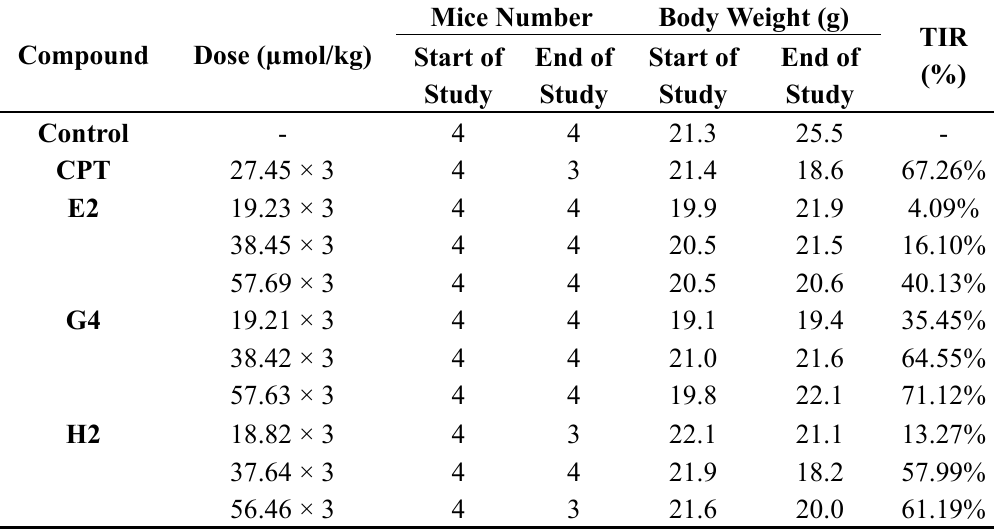
mice liver tumours. 22